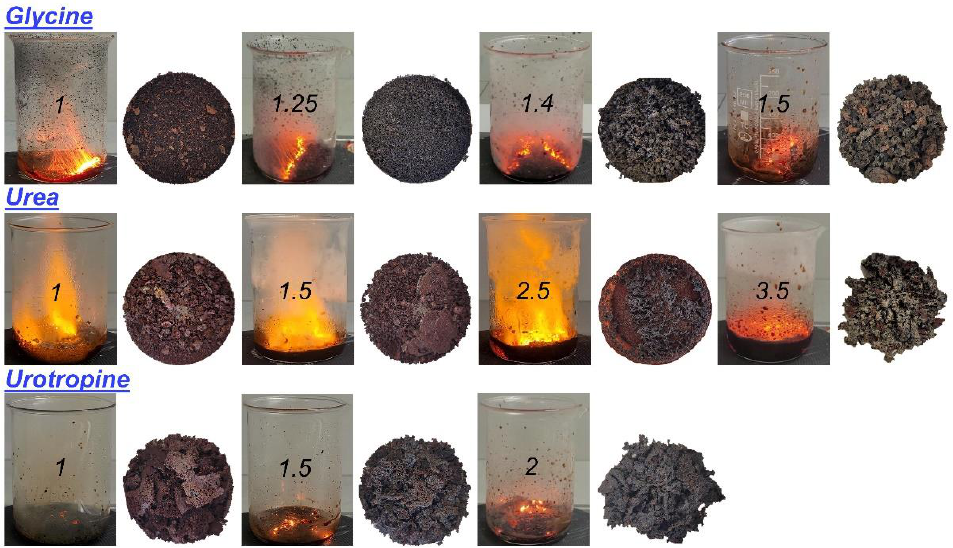
Figure 1. The course of the fuel-nitrate solution combustion and the macro morphology of the SCS products obtained at various fuel-to-oxidizer ratios.